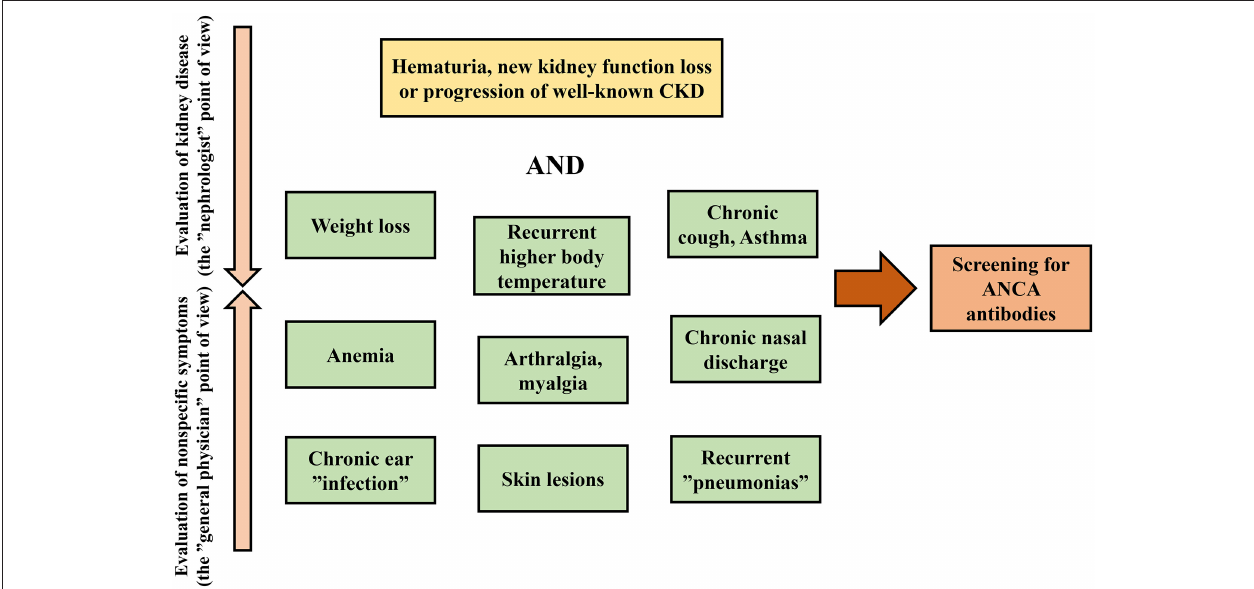
FIGURE 1 | First steps of the diagnostic approach to ANCA-associated glomerulonephritis.